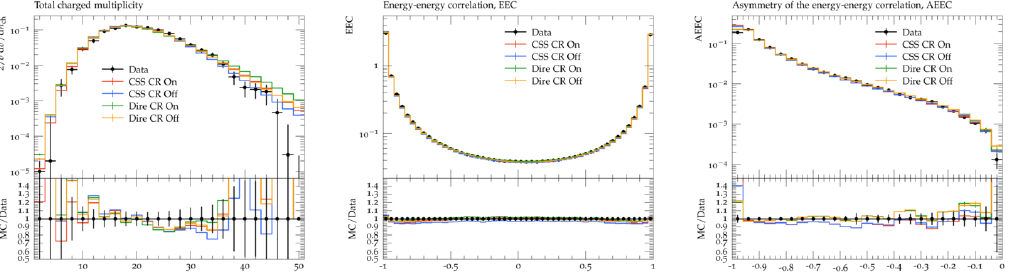
Figure 3: Multiplicities of charged hadrons (left), the energy-energy correlation (middle) and its asymmetry (right) in e − e + → hadrons at centre-of-mass energies of 91.2 GeV. The S HERPA results are compared with data from A LEPH [ 46 ] for the first, and from D ELPHI [ 47 ] for the latter